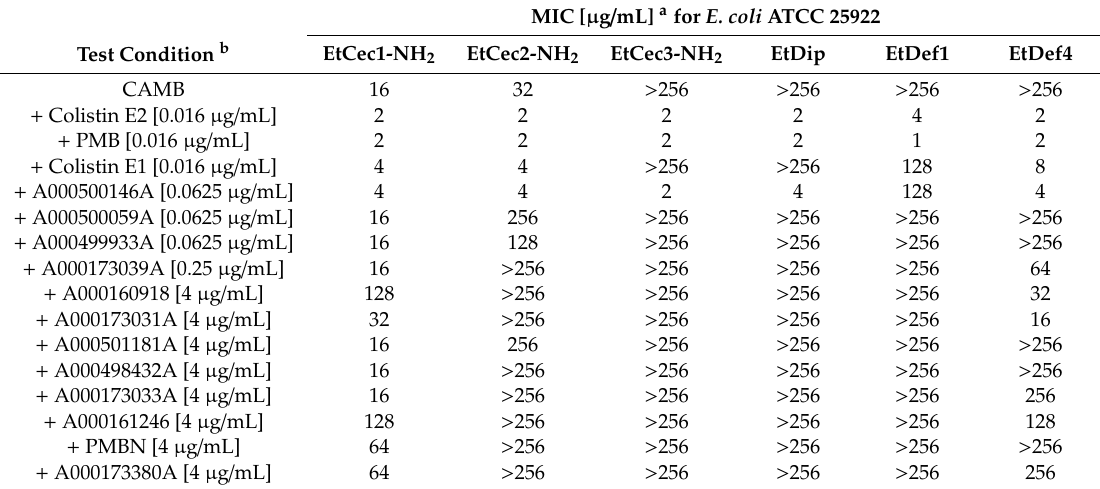
Table 6. E ff ects of sub-MIC concentrations of polymyxin derivatives on the activity of Eristalis tenax peptides against Escherichia coli ATCC